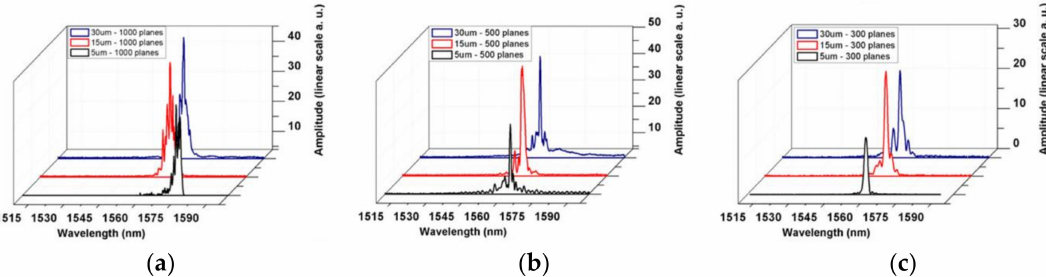
Figure 3. The grating reflection spectrum corresponding to 30, 15, and 5 µ m wide with ( a ) 1000 planes; ( b ) 500 planes; and ( c ) 300 planes [51].